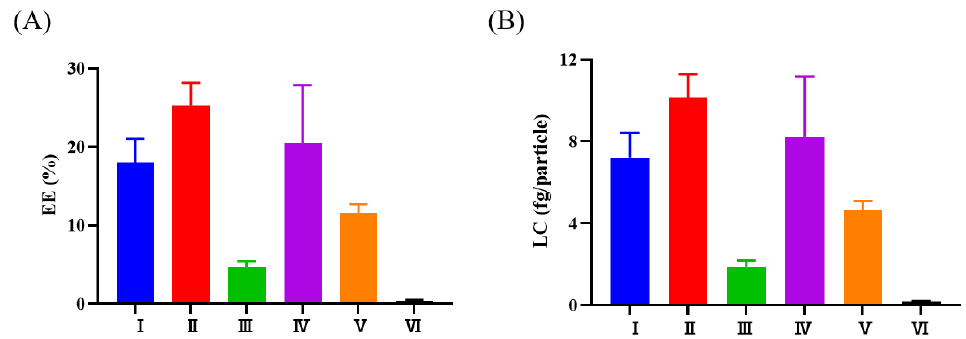
Figure 2. AST-loading methods for EVs. Measurement of ( A ) EE and ( B ) LC for AST loading into EVs using different loading methods. I, simple incubation; II, saponin-assisted incubation; III, extrusion; IV, freeze-thaw; V, sonication; VI, electroporation.